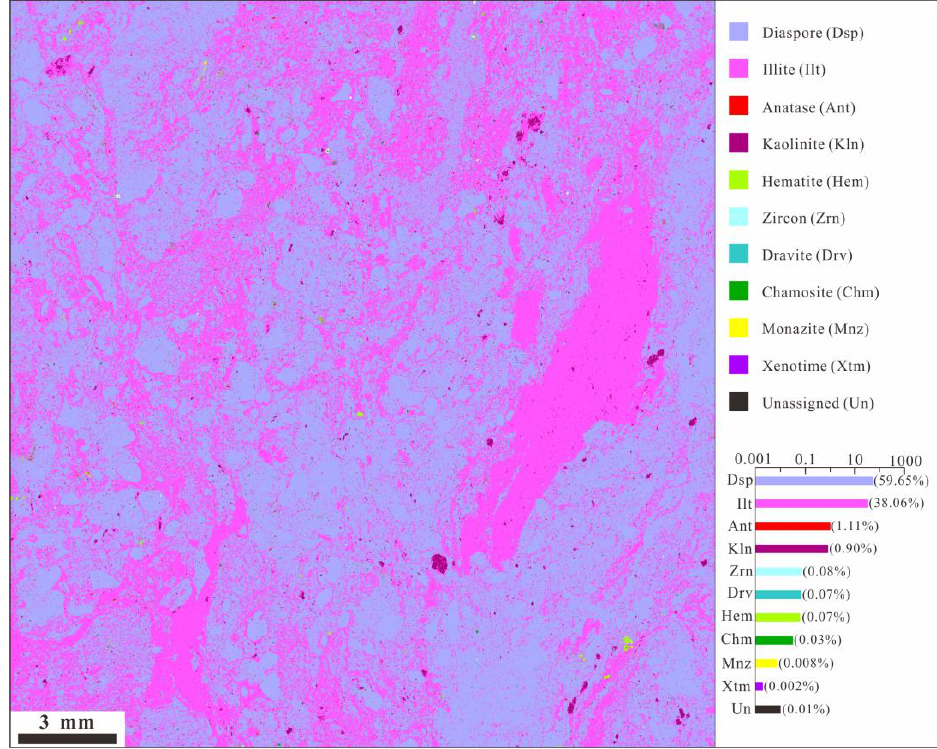
Figure 5. TIMA mineral scanning maps of the representative Lindai bauxite ore. The bar graph on the right side shows the percentage composition of mineral phases in a thin section.